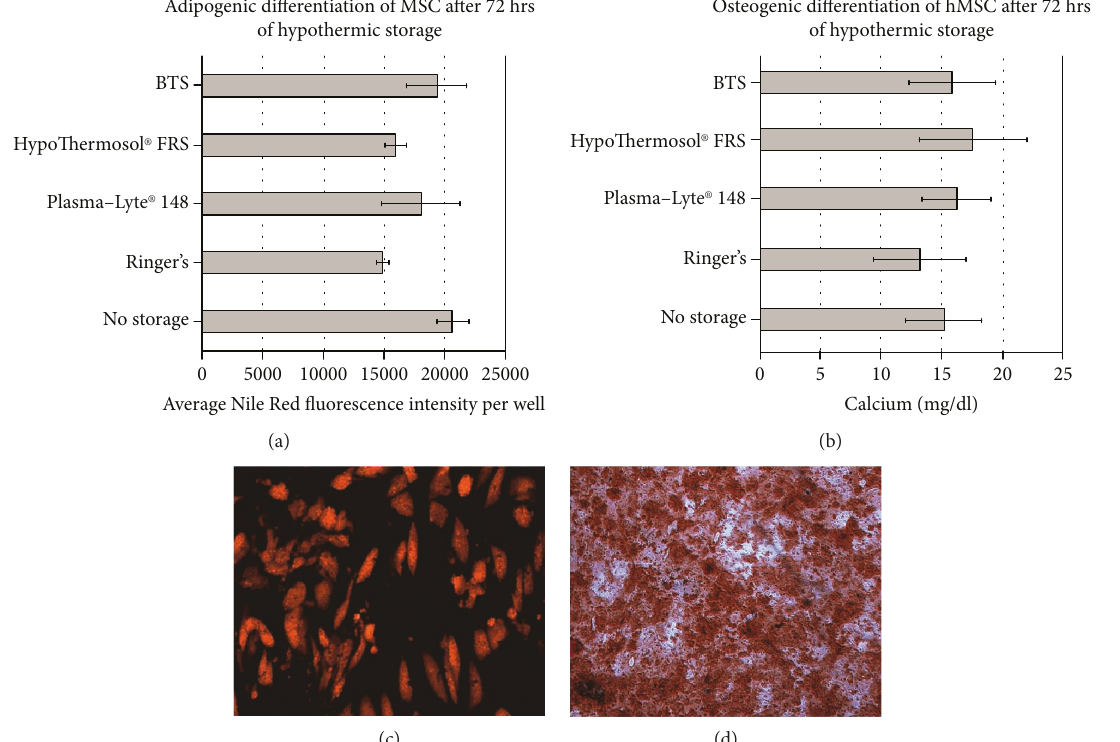
Figure 3: Adipogenic (a, c) and osteogenic (b, d) di ff erentiation of human MSCs after 72hrs of hypothermic storage in di ff erent solutions and following recultivation. (a) Average Nile Red fl uorescence intensity; (b) accumulated calcium content; (c) Nile red staining × 100; (d) alizarin red staining, × 100.